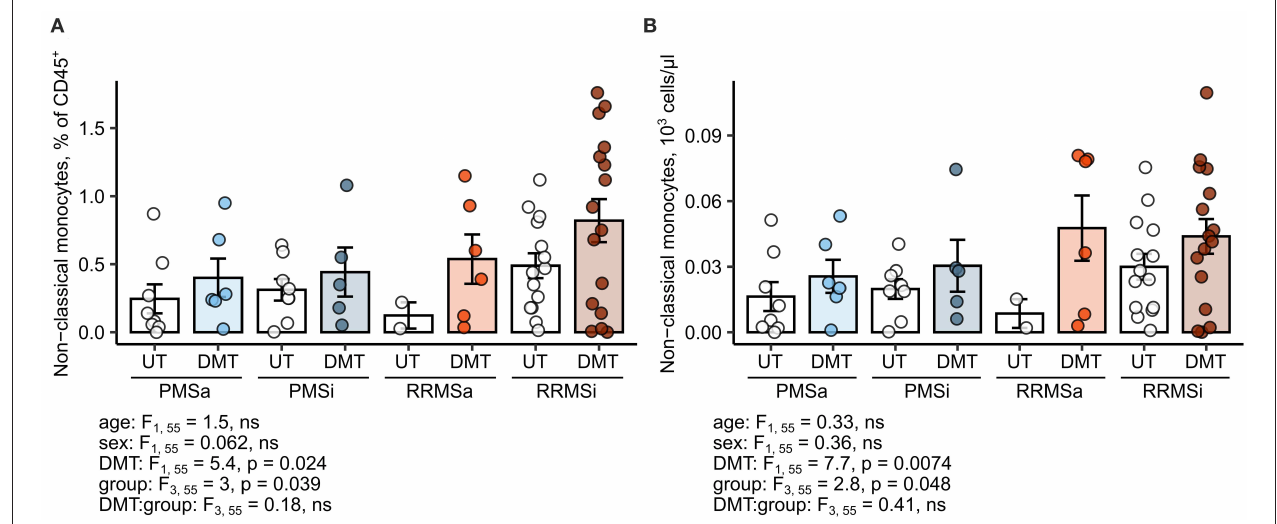
FIGURE 7 | Expansion of nonclassical monocytes in disease-modifying therapy-treated multiple sclerosis (MS) patients. Nonclassical monocytes were identified in blood samples of MS patients, from whom data on disease-modifying therapy [untreated (UT) and disease-modifying therapy (DMT)] were available [UT active progressive MS (PMSa): n = 8, DMT PMSa: n = 6, UT inactive progressive MS (PMSi): n = 8, DMT PMSi: n = 5, UT active relapsing-remitting MS (RRMSa): n = 5, DMT RRMSa: n = 6, UT inactive relapsing-remitting MS (RRMSi): n = 14, and DMT RRMSi: n = 16] as presented in Supplementary Figure S1 . Each point denotes a single observation, bars depict group-wise means, and error bars represent SEM. Statistical significance was calculated with two-way analysis of covariance (ANCOVA) (terms: study group, DMT and group: DMT interaction) with age and sex as confounders. Results of the two-way ANCOVA are presented under the plots. post hoc testing was performed with Benjamini–Hochberg-corrected two-tailed T tests. Significant results of post hoc test are presented within the plots. (A) Levels of nonclassical monocytes expressed as percentage of CD45 + blood leukocytes. (B) Levels of nonclassical monocytes expressed as counts per microliter of whole